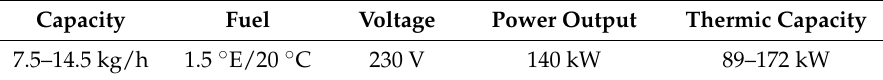
Table 2. Burner specifications (Baltur IL BT 14 G/W Light Oil